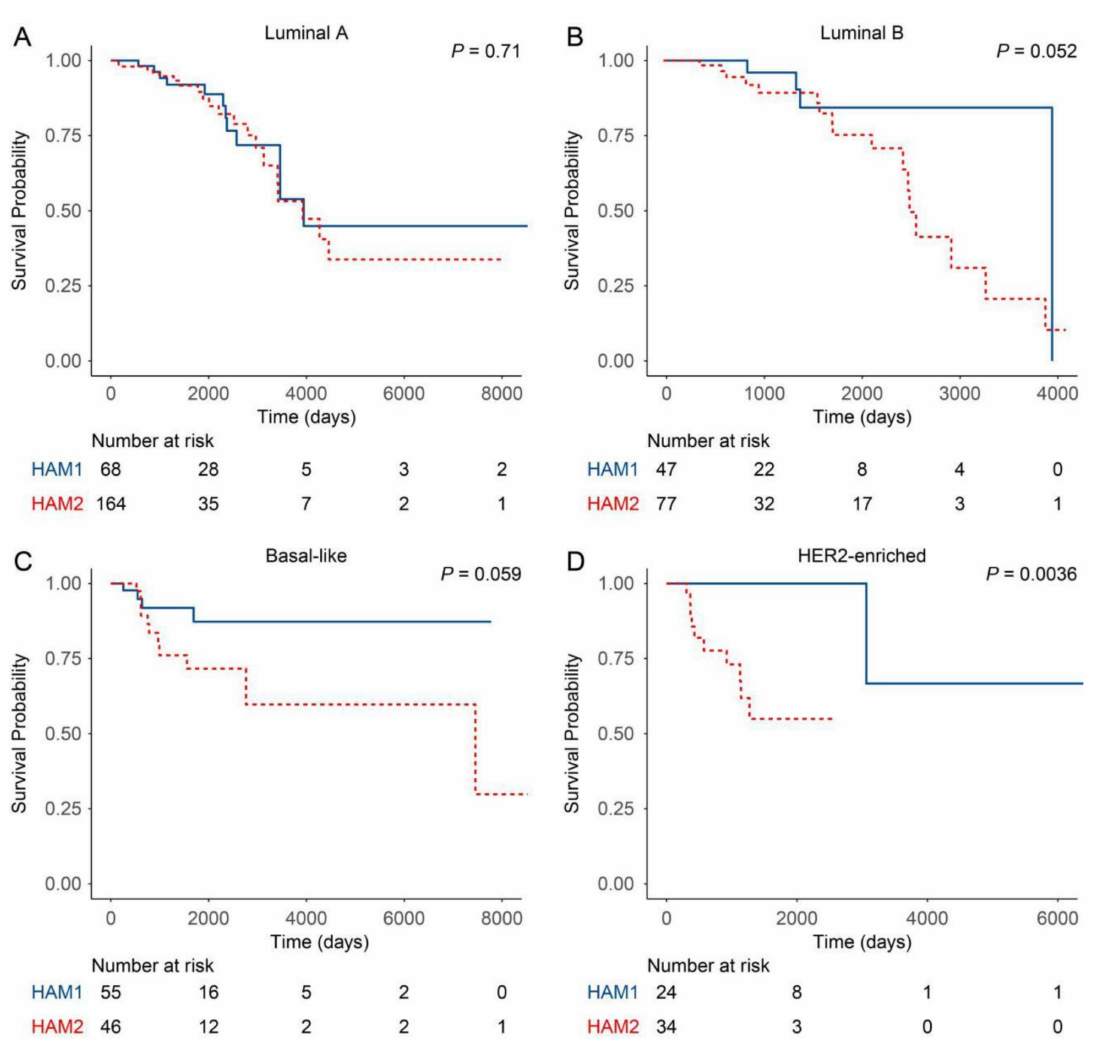
Figure 5. Kaplan–Meier estimate of the overall survival for four intrinsic subtypes between the HAM1 and HAM2